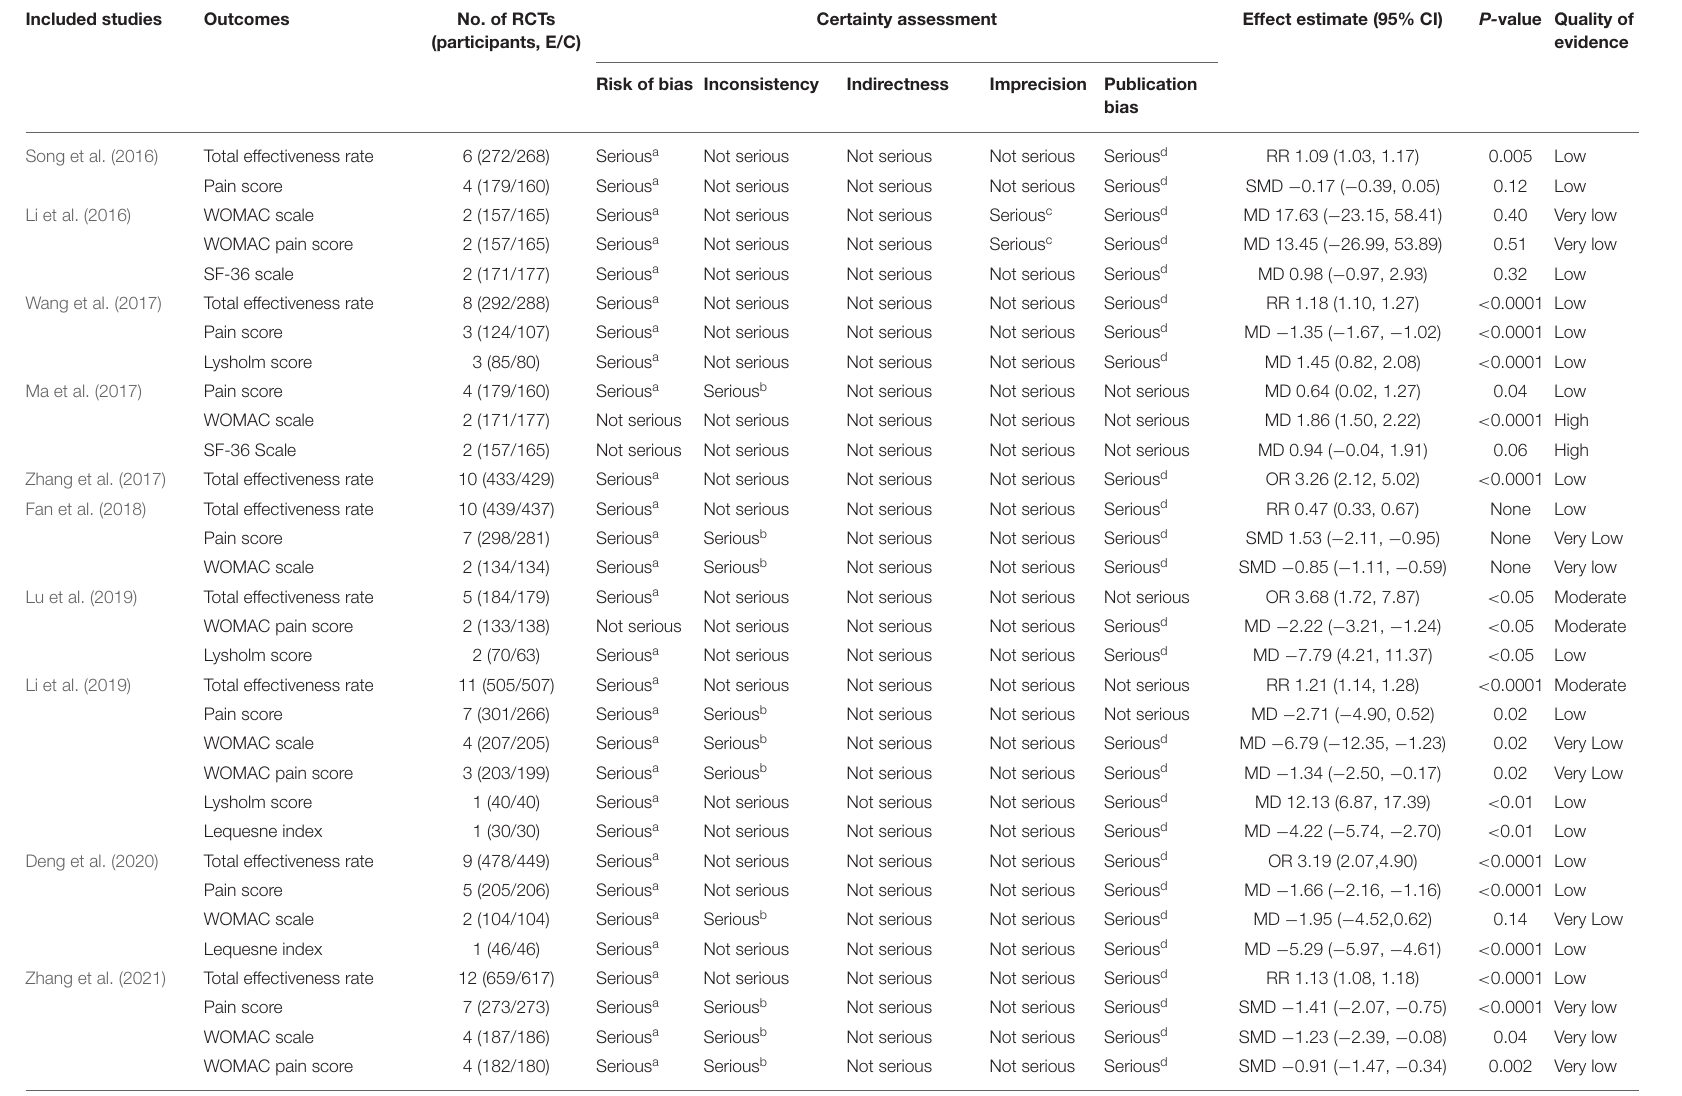
TABLE 5 | GRADE for quality of evidence